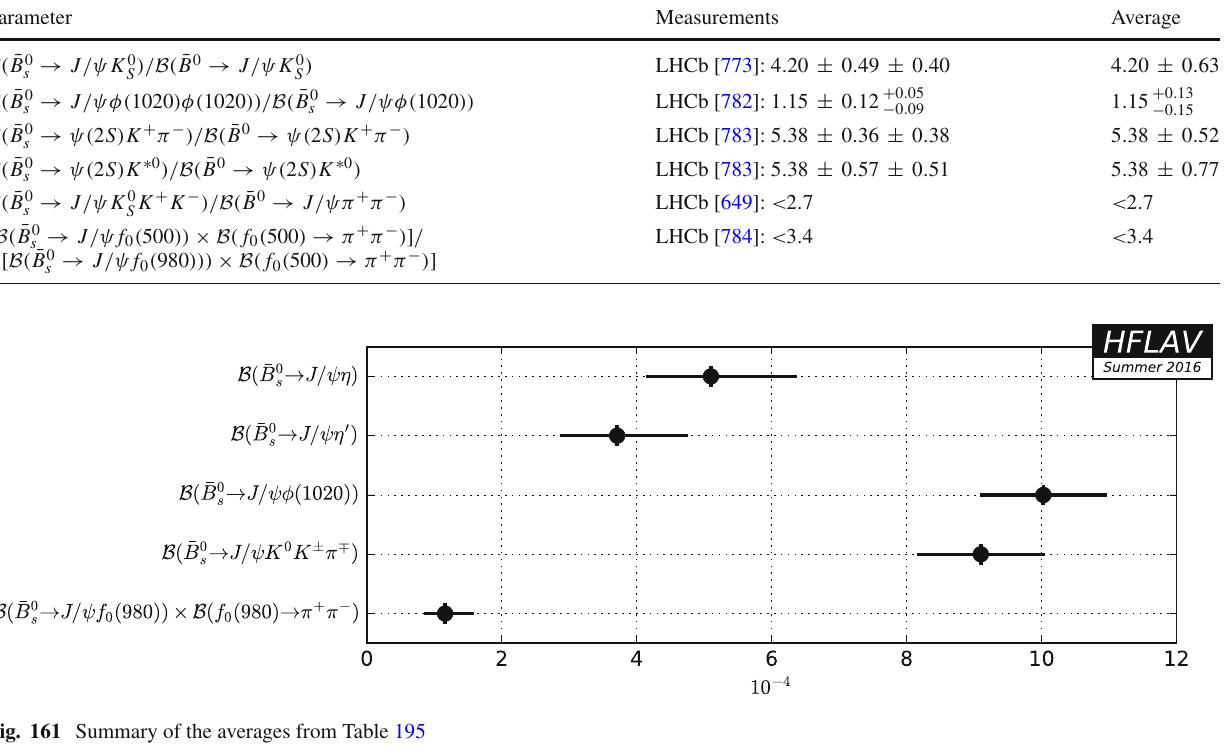
Table 199 Relative decay rates III [ 10 − 2 ]